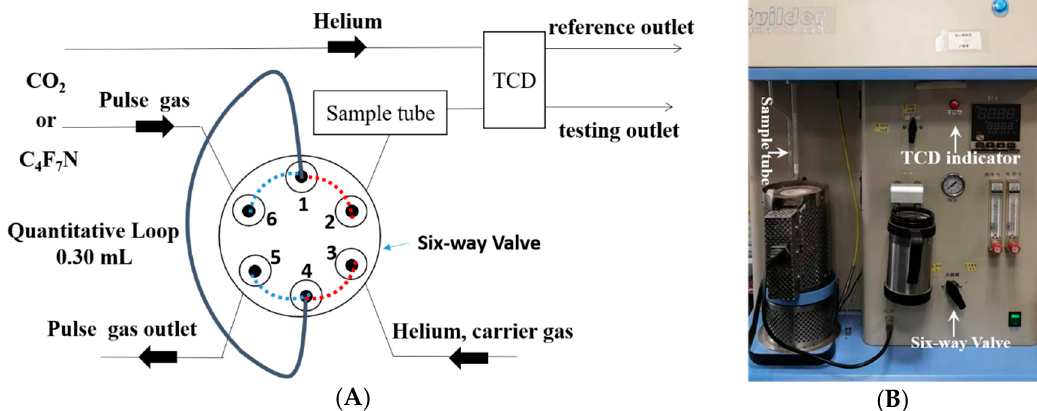
Figure 1. ( A ) Schematic and ( B ) picture of pulse adsorption test instrument (PCA-1200). TCD, thermal conductivity detector.